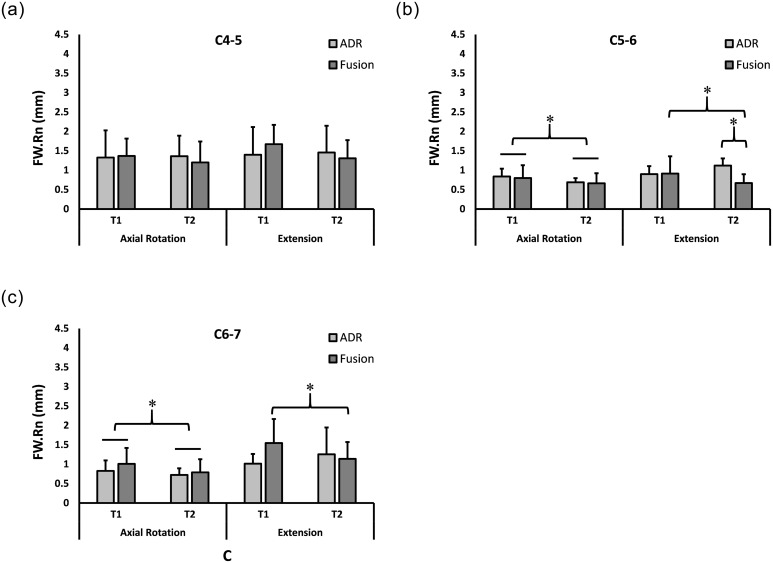
Foraminal Width Range (FW.Rn) at 2y and 6.5y.Range of foraminal width (FW.Rn) (Mean + SD) during neck axial rotation (left) and extension (right) movements at C4-5 (A), C5-6 (B), and C6-7 (C). * Statistically significant difference.